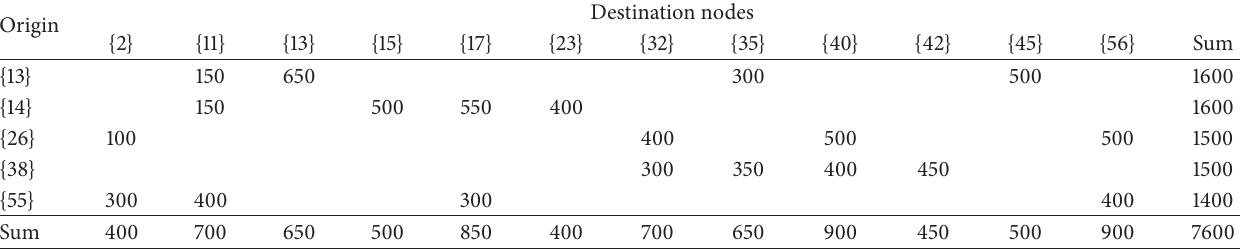
Table 1: List of origin and destination nodes (dimension = thousands M 3 per year).